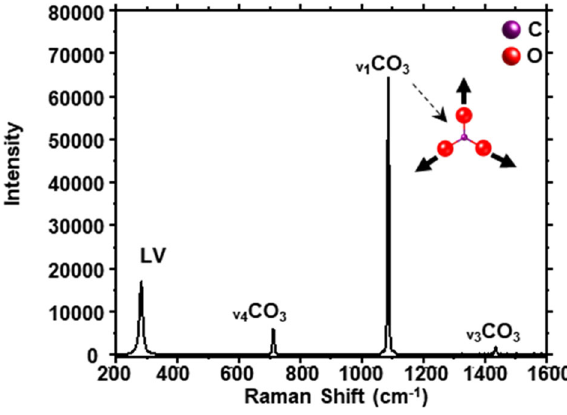
Fig. 1 Raman spectrum obtained from analytical grade CaCO 3 powders. Raman spectrum showing typical characteristic peaks and associated vibrational modes.